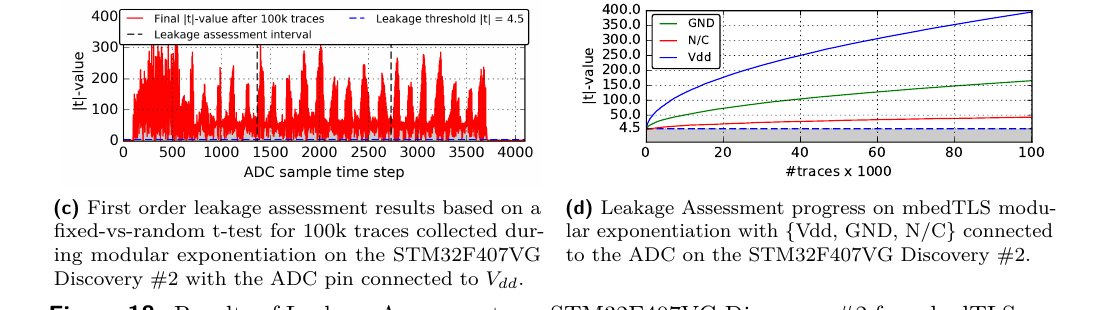
Figure 18: Results of Leakage Assessments on STM32F407VG Discovery #2 for mbedTLS modular